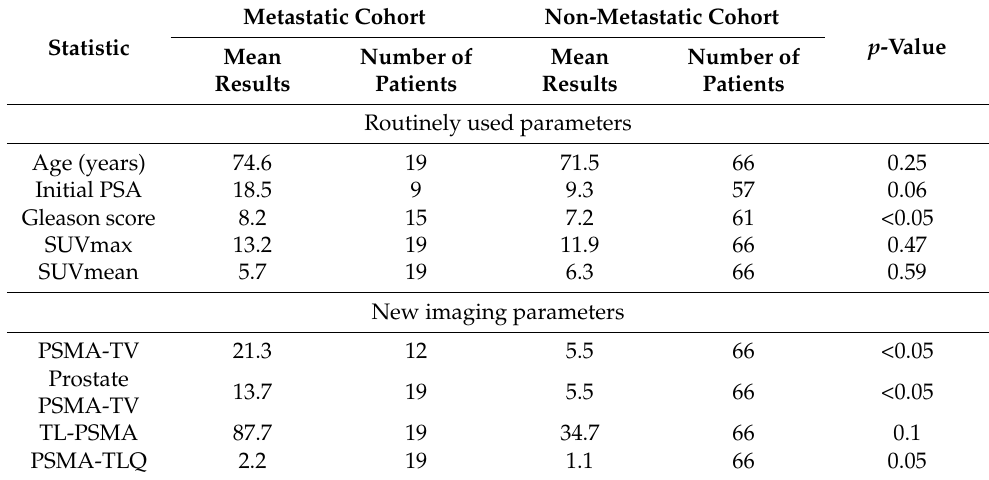
Table 2. Metastatic vs. non-metastatic cohort